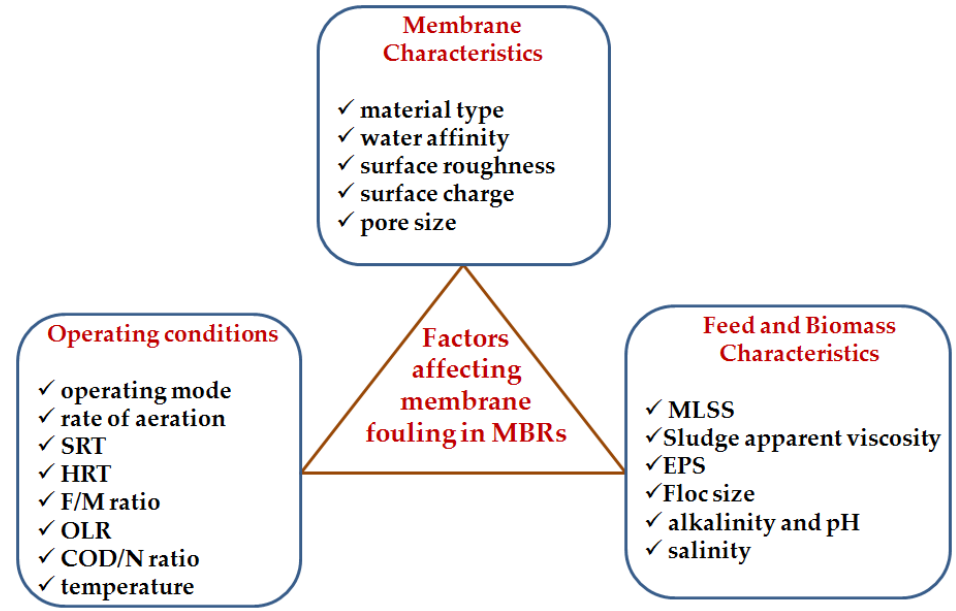
Figure 2. Factors affecting membrane fouling in MBRs.